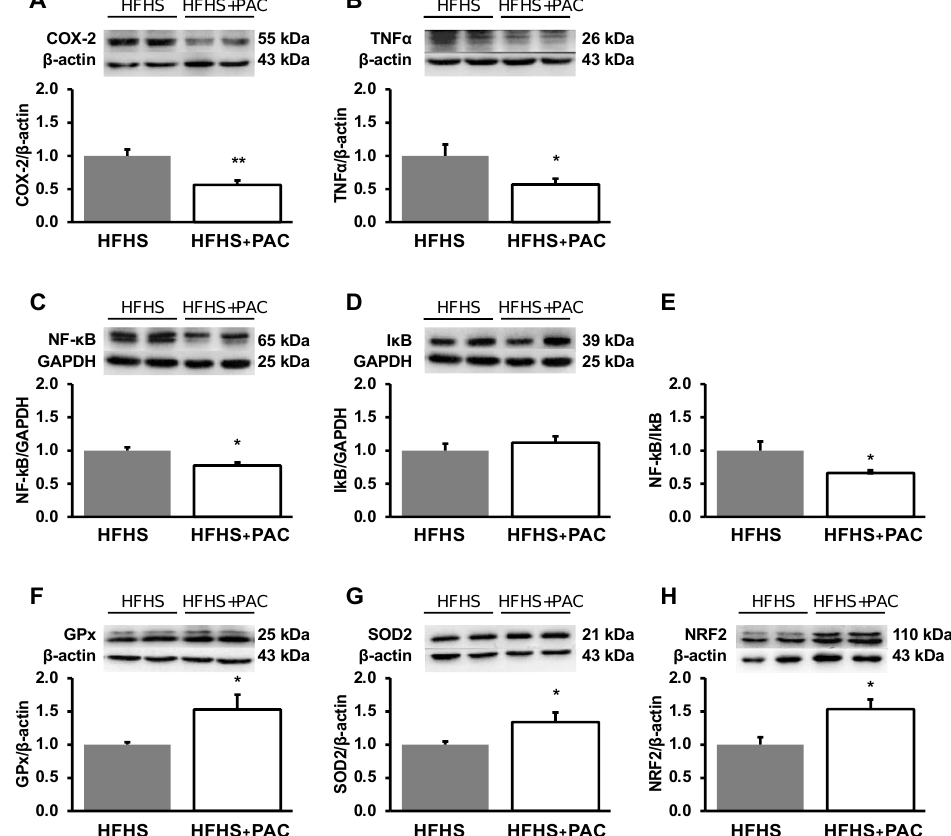
Figure 7. Effect of PACs on inflammatory and OxS processes in liver HFHS-fed mice. The protein mass of ( A ) COX-2, ( B ) TNF α , ( C ) NF- κ B and ( D ) I κ B was determined by Western blot as described in Materials and Methods. Both ( C ) NF- κB and ( D ) IκB were blotted on the same gel and normalized using the same GAPDH; the ( E ) NF-kB/I κ B ratio was then calculated. Moreover, the protein expression of the antioxidant defense biomarkers, namely ( F ) GPx, ( G ) SOD2 and the transcription factor nuclear factor ( H ) NRF2 were evaluated by Western blot as described in Materials and Methods section. Results are presented as mean ± SEM for n = 4–8 mice/group with a representative gel per experiment. * p < 0.05, ** p < 0.01 vs. HFHS mice. Each set of experiments, including the proteins of interest and their β -actin or GAPDH (as a reference protein and a loading housekeeping control) was run on the same gel.